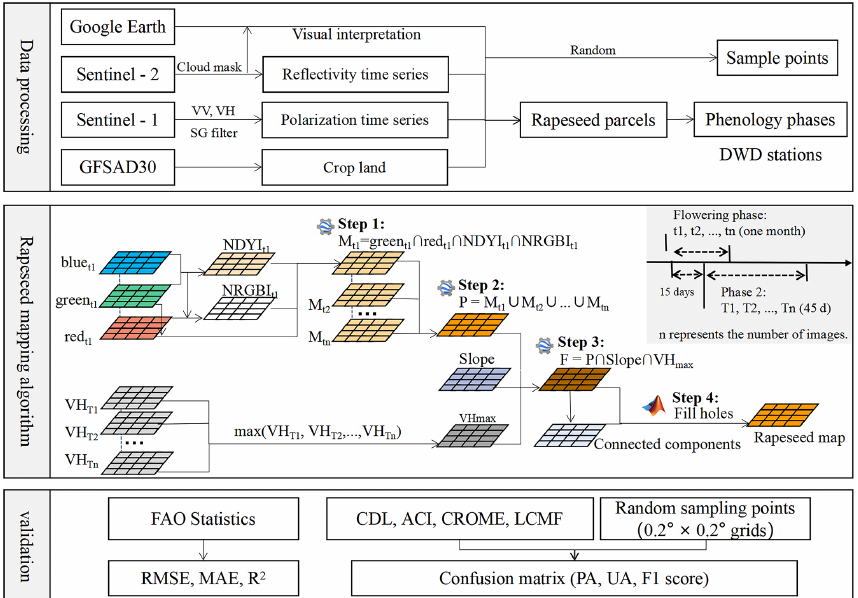
Figure 6. Workflow for mapping rapeseed areas using the proposed phenology- and pixel-based algorithm. GFSAD30, Global Food Security- Support Analysis Data at 30m; NDYI, normalized difference yellowness index; NRGBI, the new spectral index; DWD, Deutscher Wetter- dienst; FAO, Food and Agriculture Organization of the United Nations; RMSE, root-mean-square error; MAE, mean absolute error; R 2 , R -squared; CDL, Cropland Data Layer; ACI, Annual Crop Inventory; CROME, Crop Map of England; LCMF, Land Cover Map of France; UA, user’s accuracy; PA, producer’s accuracy; F1, F1